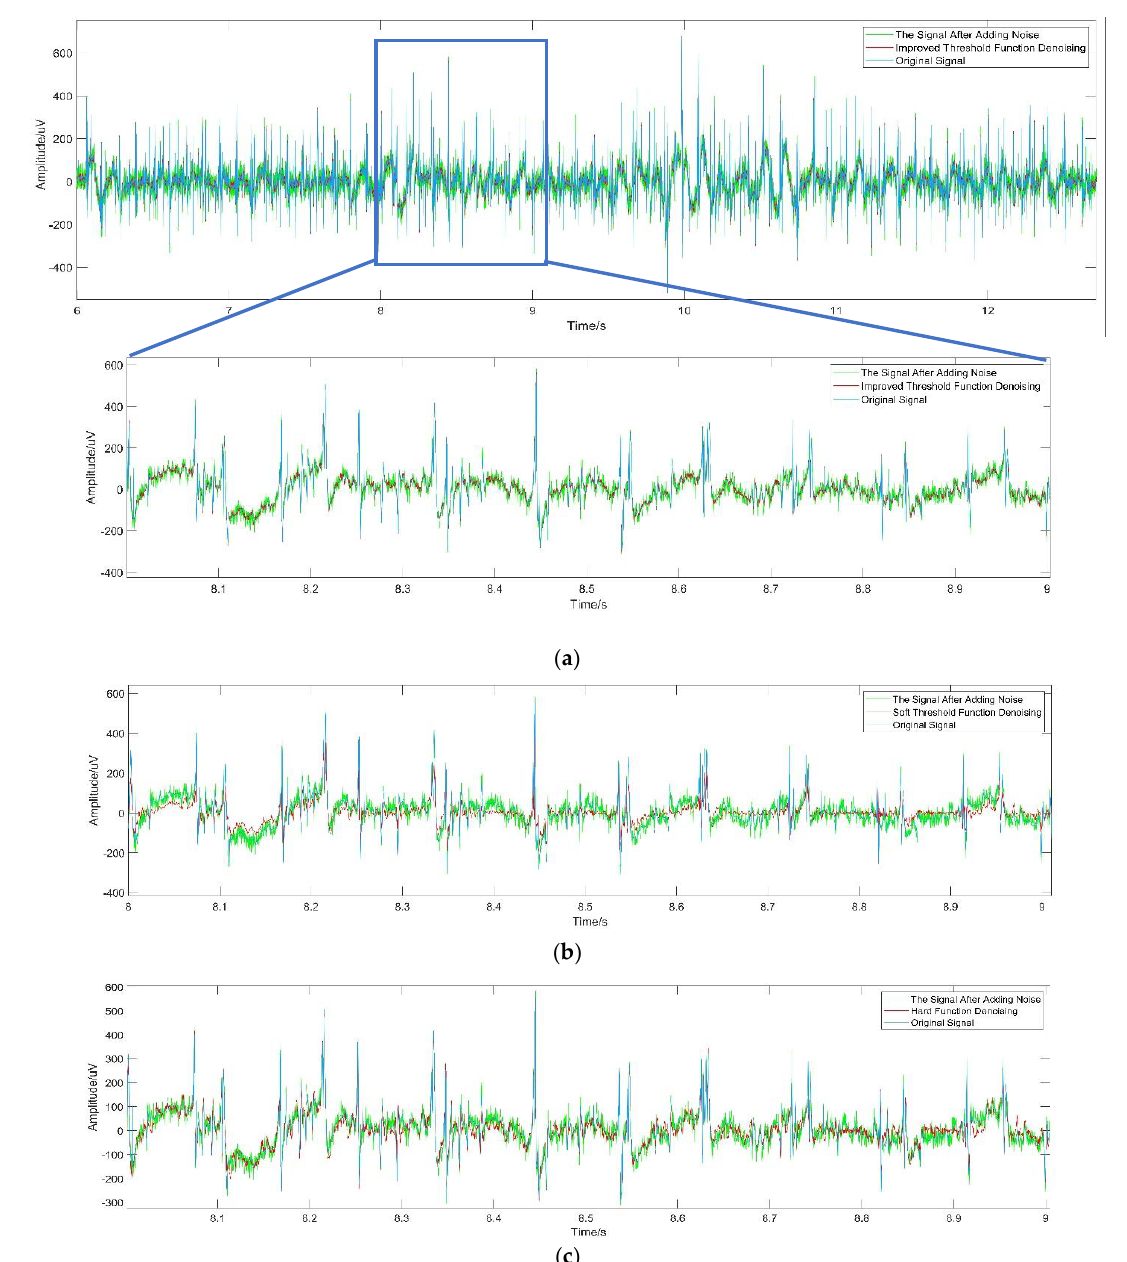
Figure 7. ( a ) Improved threshold function denoising for the EMG signal; ( b ) Soft threshold function denoising for the EMG signal; ( c ) Hard threshold function denoising for the EMG signal. Table 2. Denoising results of the three threshold functions.